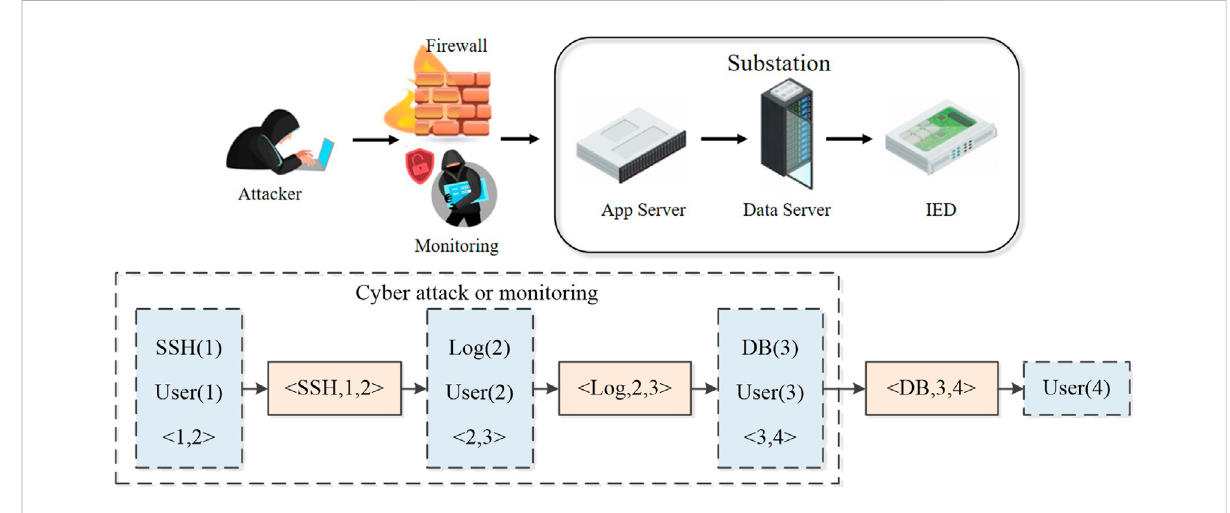
FIGURE 2 Bayesian attack graph model of substation under cyber attack.